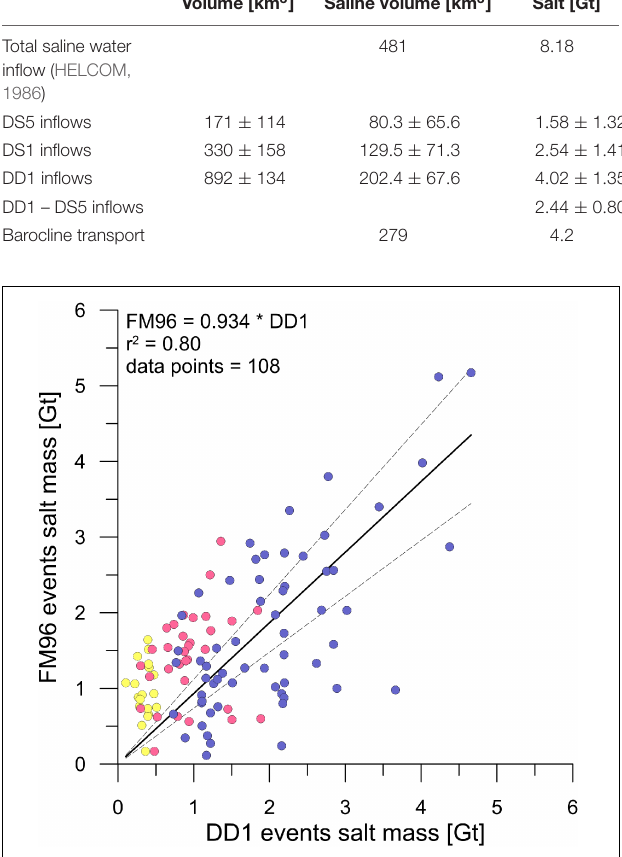
FIGURE 7 | Correlation of FM96 events and related inflow events of the subsets DS5 (blue), DS1 (red) and DD1 (yellow). A fit through origin and its 99% confidence interval is indicated by the black solid and dashed lines.